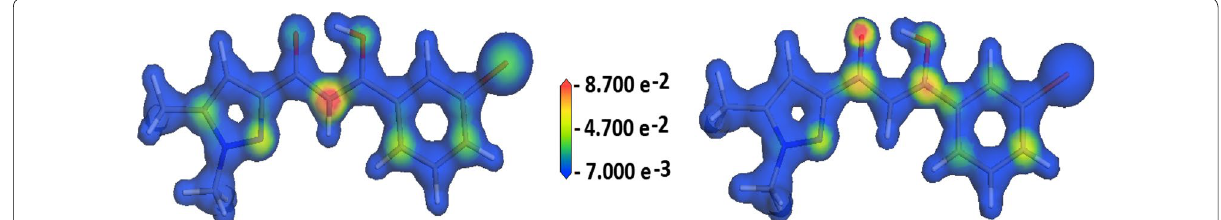
Fig. 5 Atomic spin density spatial distribution mapped onto the electrostatic potential showing the electrophilic (left image) and nucleophilic (right image) centers as red